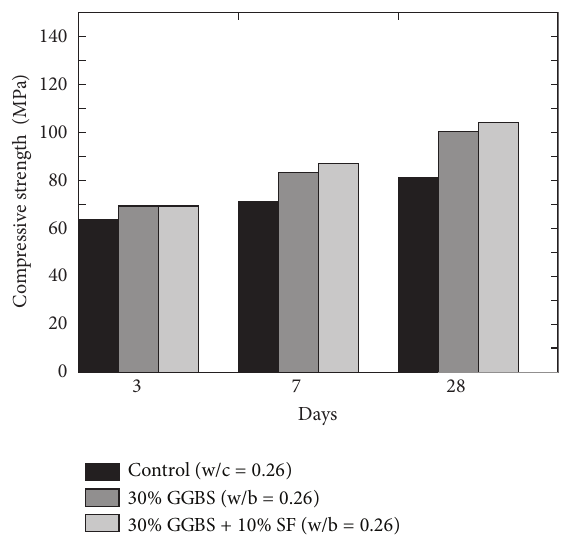
Figure 9: Effect of plain and blended GGBS on the compressive strength of GGBS concrete [9].